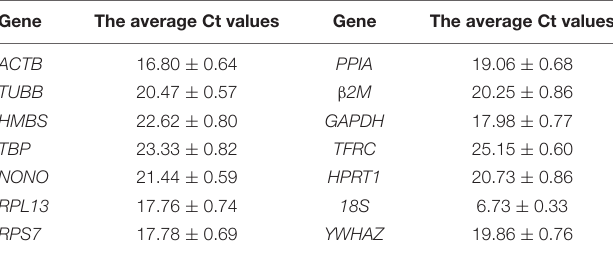
ACTB, beta-actin; TUBB, tubulin beta class I; HMBS, hydroxymethylbilane synthase; TBP, TATA box binding protein; NONO, non-POU domain containing, octamer-binding; RPL13, ribosomal protein L13; RPS7, ribosomal protein S7; PPIA, peptidylprolyl isomerase A; β 2M, beta-2 microglobulin; GAPDH, glyceraldehyde-3-phosphate dehydrogenase; TFRC, transferrin receptor; HPRT1, hypoxanthine guanine phosphoribosyl transferase 1; 18S, 18S ribosomal RNA; and YWHAZ, yrosine 3-monooxygenase/tryptophan 5-monooxygenase activation protein